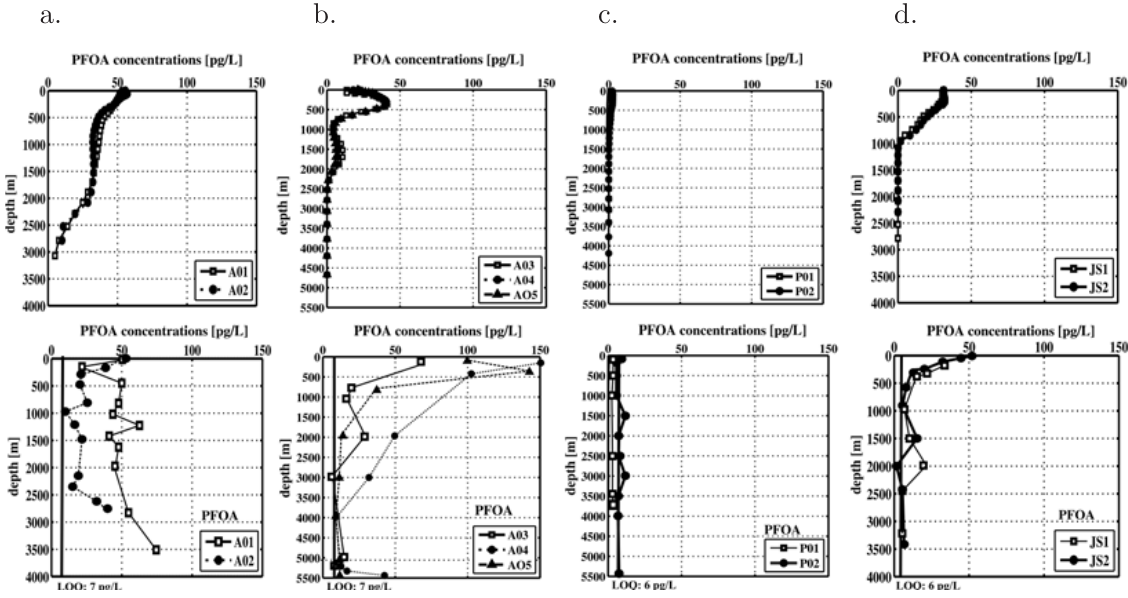
Fig. 4. Vertical profiles of PFOA concentration [pgL − 1 ] in the Labrador Sea (AO1, AO2), Mid Atlantic Ocean (AO3, AO4, AO5), Sea of Japan (JS1, JS2), and the South Pacific Ocean (PO1,PO2); upper panels model results, lower panels observations (Yamashita et al., 2008). (a) September 2004, AO1: 56 ◦ 34 0 N 52 ◦ 48 0 W, AO2: 56 ◦ 41 0 N 39 ◦ 40 0 W (b) March 2004, AO3: 23 ◦ 17 0 N 64 ◦ 19 0 W, AO4: 25 ◦ 47 0 N